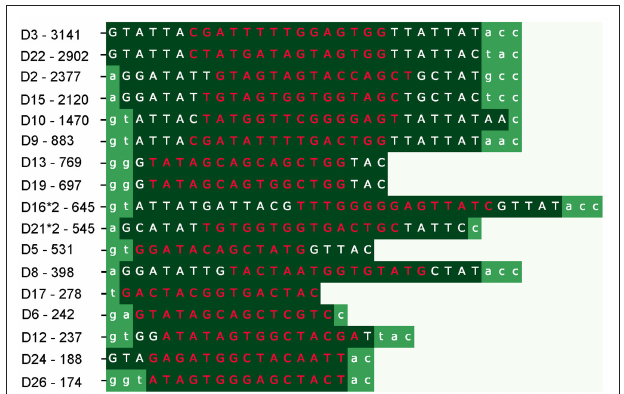
FIGURE 2 | IgScout results on the CDR3 * dataset. Each row shows a reconstructed string (strings are inferred in the order from the top to the bottom ). Dark green segments correspond to reconstructed substrings of human D genes (flanking non-reconstructed nucleotides are shown in standard green). The most frequent 15-mers that were used for reconstructing the corresponding D genes are shown in red (their abundances are shown on the left). The reconstructed substring of the D2 gene (IGHD2-2) also occurs in D2*2 and D2*3 genes. Seventeen strings reconstructed by IgScout represent substrings of 17 human D genes. IgScout misses short prefixes and suffixes of D genes: 1.4 nucleotides on the left and 1.7 nucleotides on the right, on average for the Set 1 dataset (0.9 nucleotides on the left and 1.5 nucleotides on the right, on average after combining reconstructions over all HEALTHY datasets). IgScout did not reconstruct eight human D genes: D1 (IGHD1-1), D4 (IGHD4-4), D7 (IGHD1-7), D14 (IGHD1-14), D20 (IGHD1-20),